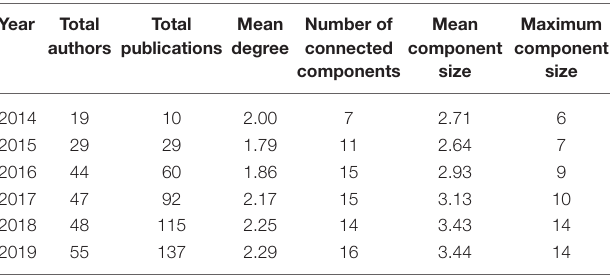
TABLE 3 | Network statistics for workshop participants’ publication coauthorship network, 2014–2019.